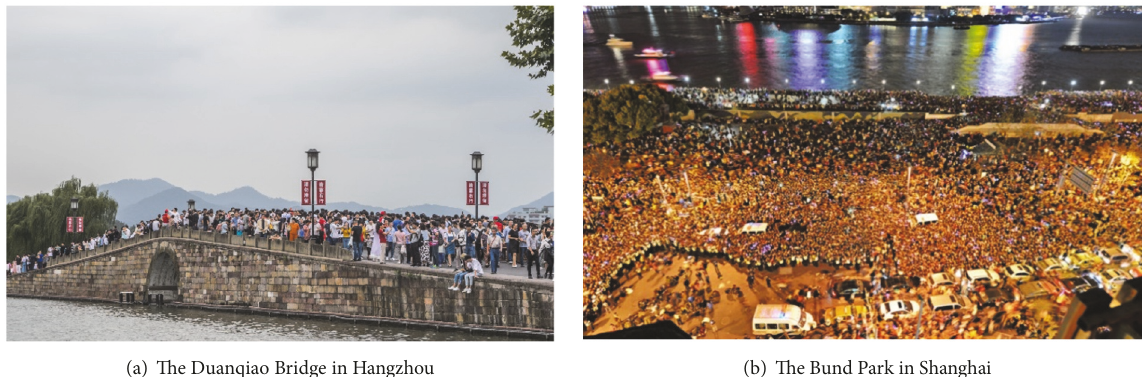
Figure1:Scenariosforpilgrims/tourists((a)isdownloadedfromhttp://www.163.com,and(b)isdownloaded fromhttps://baike.baidu.com/).